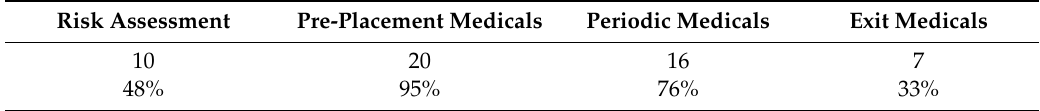
Table 4. Availability of exposure or disease prevention services.